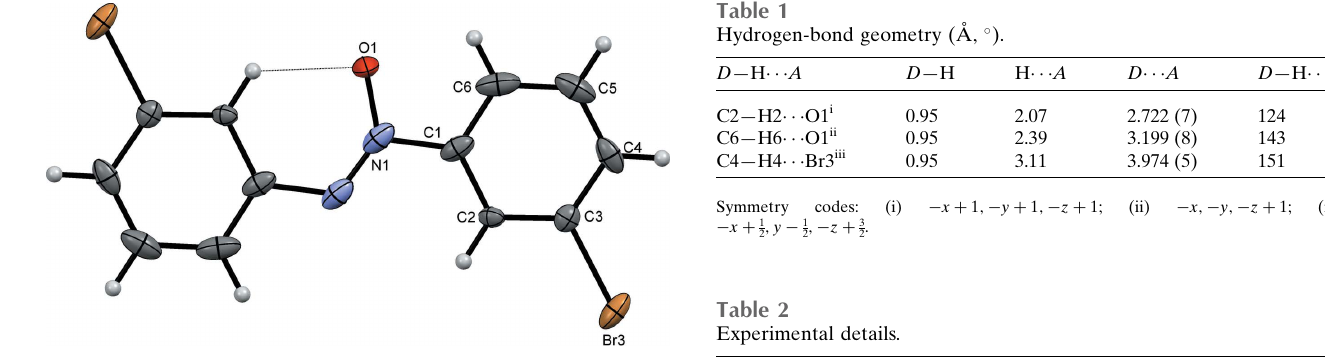
Figure 1 The molecular structure of (I) showing the atom numbering with ellipsoids drawn at the 50% probability level. Labelled atoms are related to unlabelled atoms by the symmetry operation (cid:5) x + 1, (cid:5) y + 1, (cid:5) z + 1. An intramolecular hydrogen bond is drawn as a dotted black line. In this and subsequent figures, the equivalent disorder component of the O1 atom is not